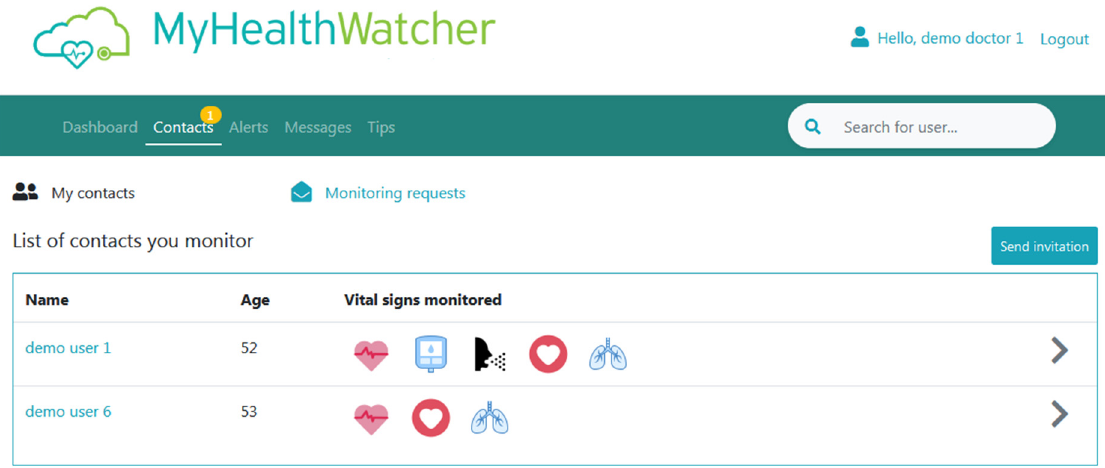
Figure 17. Screenshot of Contacts main page—current UI implementation.